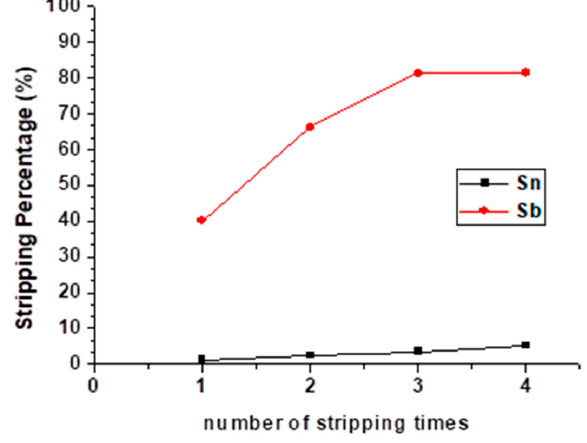
8 of 12 Figure 8. Stripping percentage of Sn and Sb at different reaction times. (HCl) = 9 M, O/A ratio = 1. 3.2.5. Stripping Efficiency of Repetitive Operation Since the stripping efficiency of Sb was only 40.02% even in the optimal condition, to